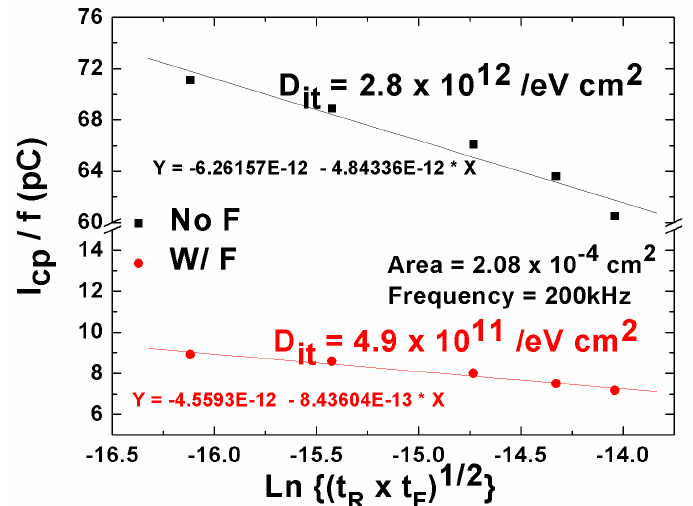
Figure 12. Q according to References [14,15]. Samples with F incorporation show less D 4.9 × 10 11 /eVcm 2